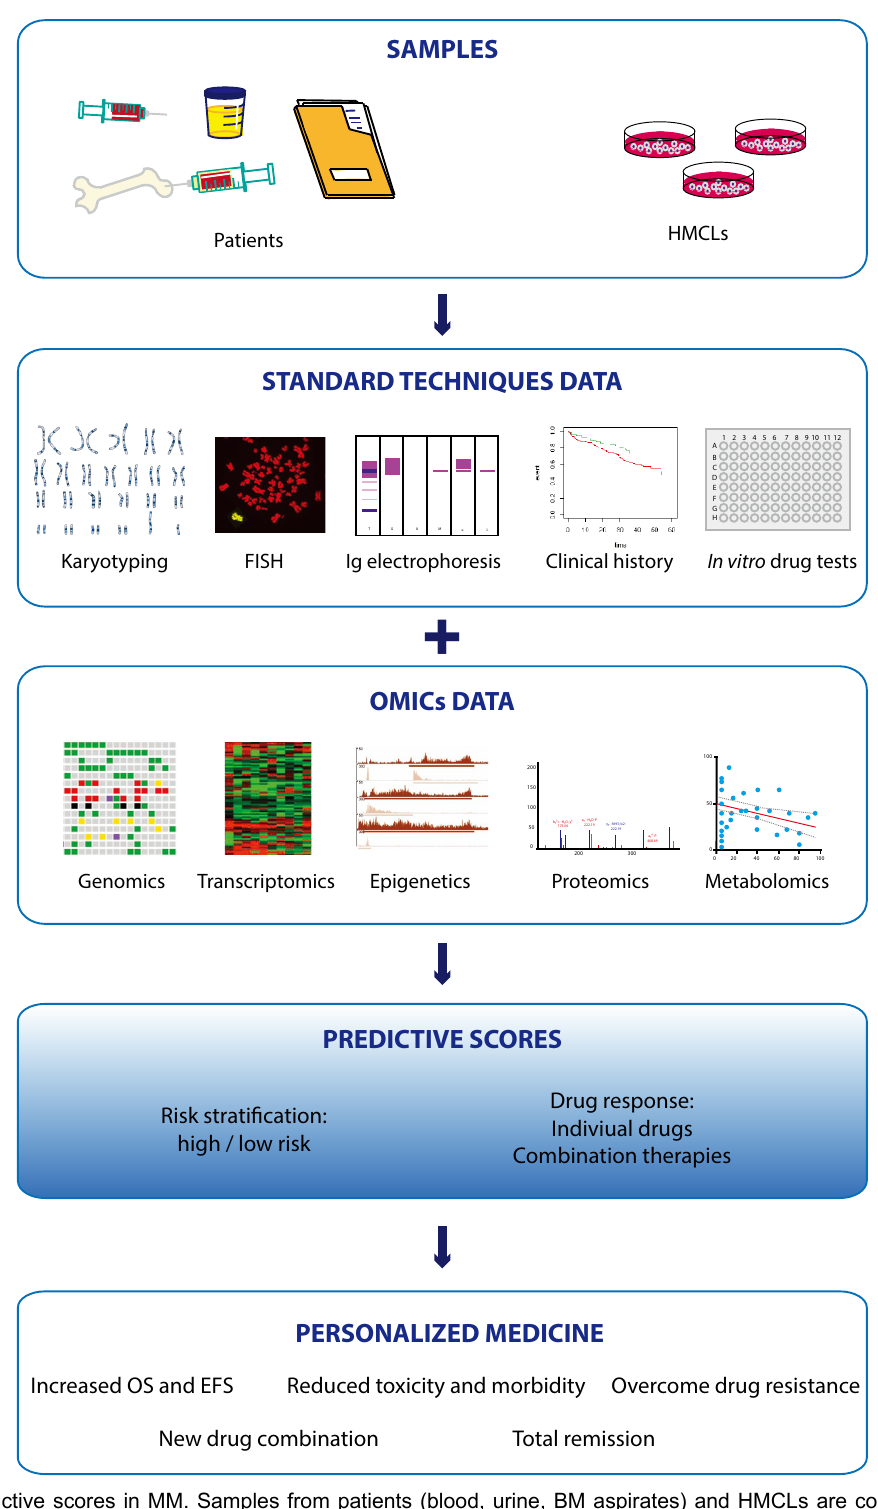
Figure 1. Predictive scores in MM. Samples from patients (blood, urine, BM aspirates) and HMCLs are commonly studied by classical diagnosis techniques. Karyotyping and fluorescence in situ hybridization allow the detection of CNA and translocations, respectively; electrophoresis detects Ig chains in serum and urine from patients; clinical history collects data about lines of treatment, relapse, progression free survival, overall survival, MRD, and co-morbidities, that are crucial when analyzing cohorts of patients. Primary cells from patients and HMCLs can be used to assess the efficacy of in vitro drug treatments and drug combinations in order to find new therapeutic approaches. The integration of data from these routine techniques with omics obtained data, specially from genomics and transcriptomics studies, allows to build scores (Tables 3 and 4) capable to stratify the risk or predict drug response, that are instrumental for personalized treatment. Combination of several scores will refined diagnosis and improve the monitoring of the evolution of the disease. Finally, since drug resistance is the main reason of relapse, personalized medicine based on omics-developed scores will allow to choose the best drug for each patient, increasing the probability of survival while reducing treatment-associated toxicity, which also translates in better quality of life. It includes a karyotyping cartoon (Karyotyping) taken from an open source: